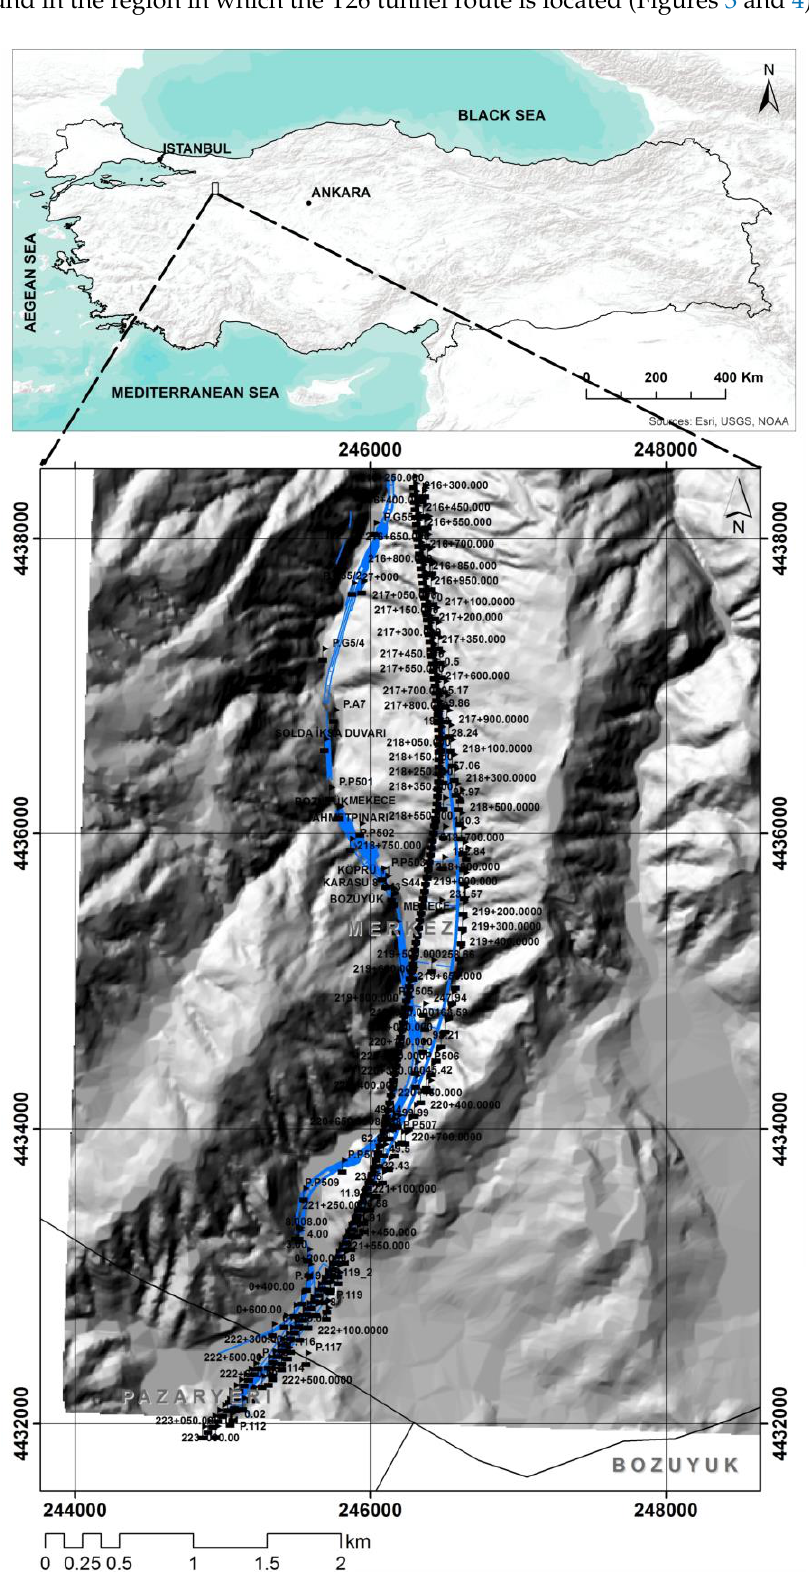
Figure 1. Location map of the T26 tunnel; the high-speed train route is indicated using the black line, and the highway is represented using the blue line.